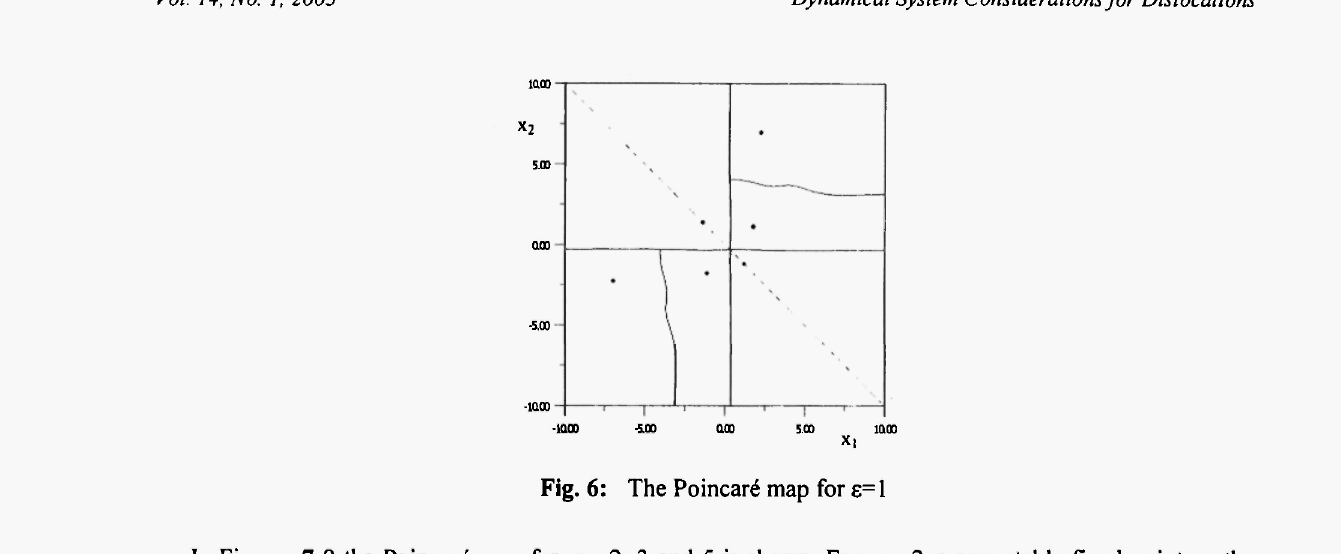
Fig. 6: The Poincari map for ε =1